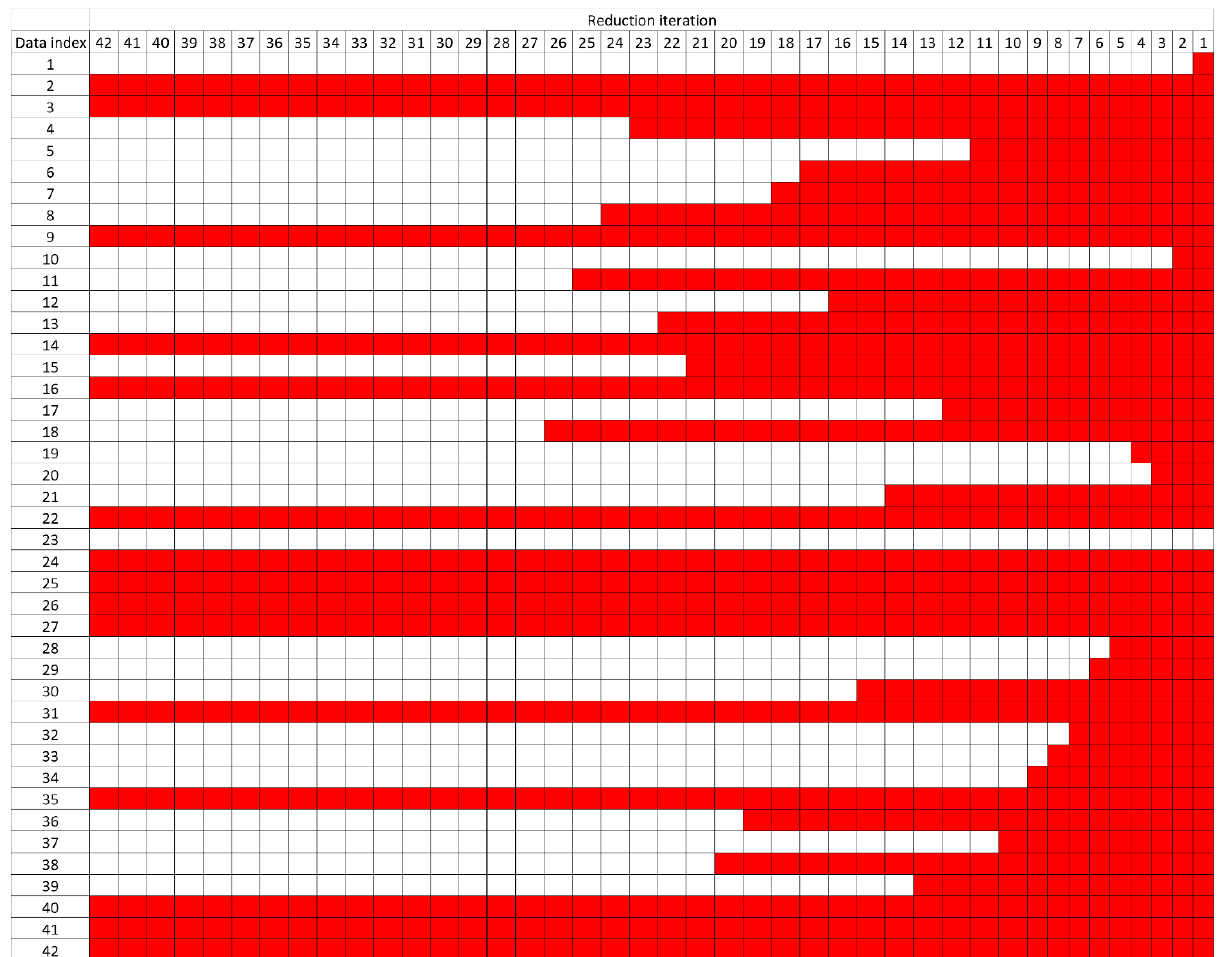
Figure 7. Iteration indices at which each input data is removed from Model AB.